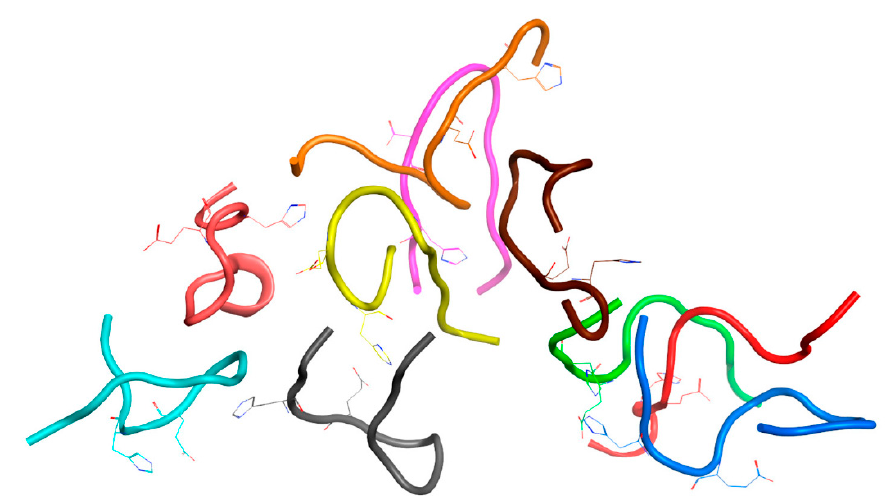
Figure 4. Results of 100 ns MD simulation of the A β 16 System 3 from Table 1 (C zn = 0). The largest cluster is shown. Box size is 15 nm. The A β 16 molecules are shown with different colors. Zinc coordinating side chains are shown. There is no zinc in this system. Table 2. MD simulation results for the systems from Table 1 containing A β 16 with various zinc concentrations.